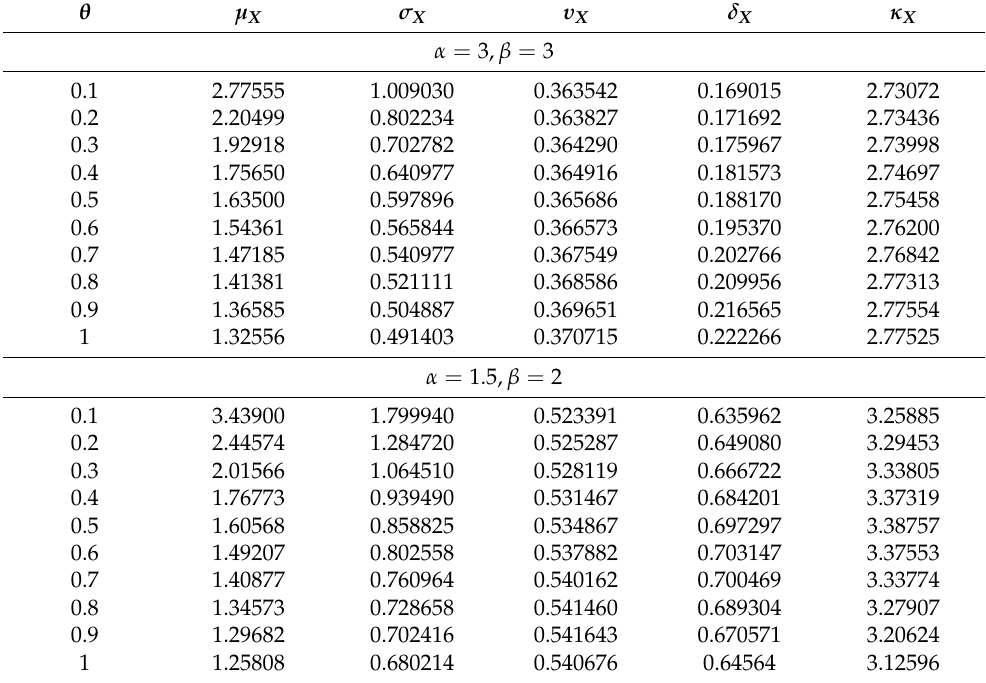
Table 1. The values of µ X , σ X , υ X , δ X , κ X of the